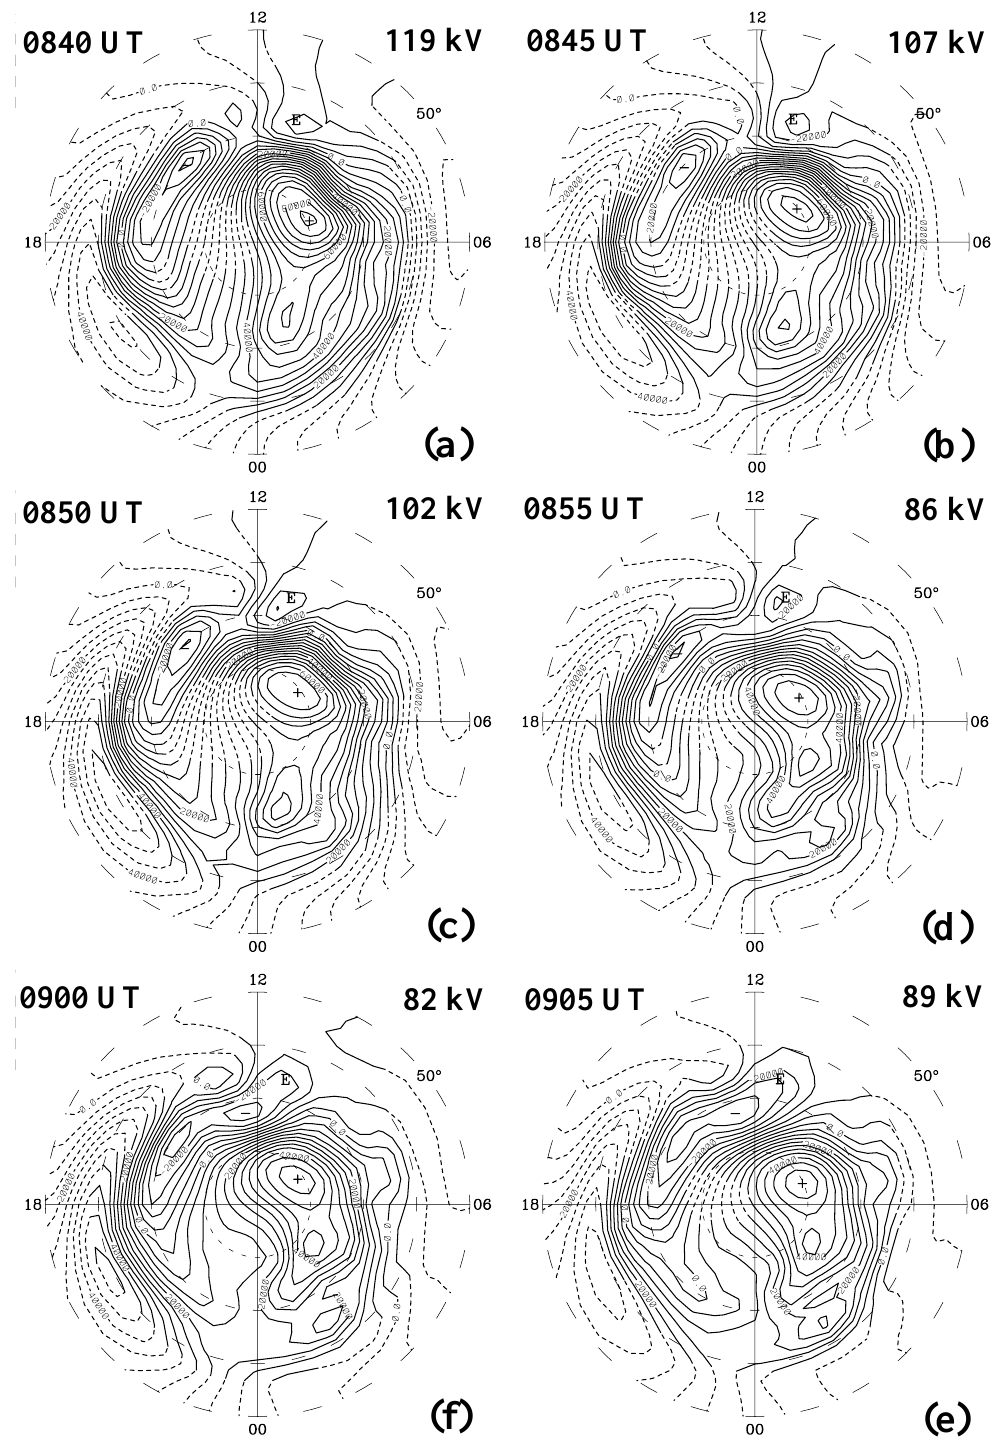
Fig. 4. Convection patterns on 15 May 1997 derived from AMIE. The letter “E” represents the location of EISCAT (near 11:00 MLT). The convection contours are shown as solid lines where the AMIE procedure infers an uncertainty in the large-scale electric field of less than 50%, and as dashed lines where the uncertainty exceeds